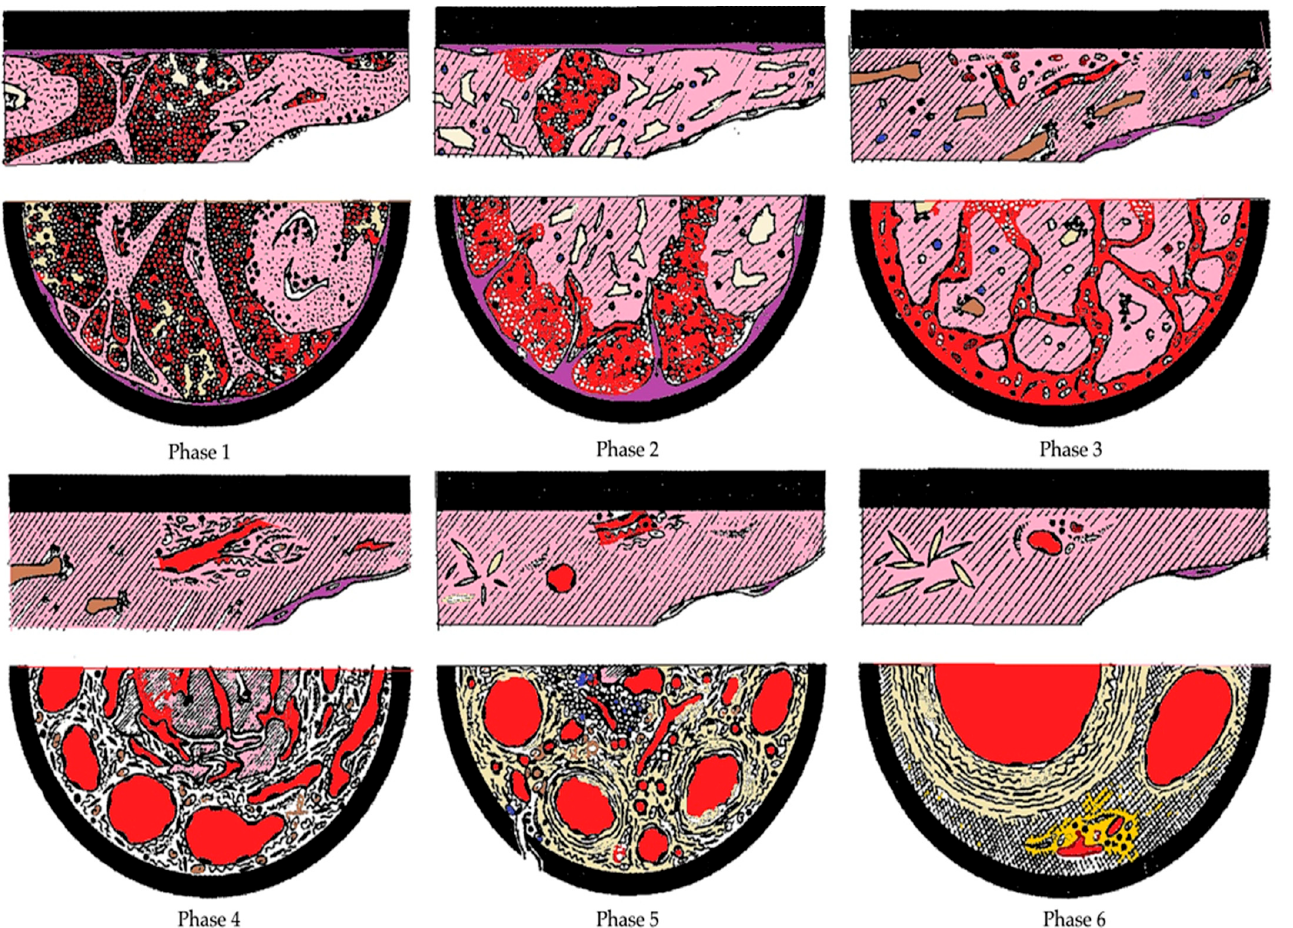
Figure 2. Images of the chronology of the microscopic changes related to the organization of the thrombus. Phase 1: Absence of reaction between endothelium and thrombus; leukocytes, platelets, and fibrin streaks are unaffected; erythrocytes agglomerated centrally and scattered peripherally. Phase 2: At day five, penetration of endothelial buds; initial hyalinization, mainly central; pycnotic leukocytes and mononuclear cells enlarged; thrombus contraction may create fissures and cavities with erythrocytes inside. Phase 3: By day 10, first capillaries, fibroblasts, mesenchymal cells and histiocytes with accumulations of hemosiderin; thrombus hyalinized and divided into large clumps; residual leukocyte nuclei. Phase 4: From week four, argyrophilic fibers and collagen; numerous capillaries. Phase 5: From the eighth week to the eighth month, completely hyalinized thrombus and presence of fusiform cholesterol crystals; vascularized loose connective tis- sue; centrally sinuous spaces traversable by fresh blood. Phase 6: After the sixth month, almost complete recanalization through large vessels separated by compact, fibrous connective tissue poor in cellular elements (modified from Irninger W. et al. [31]).